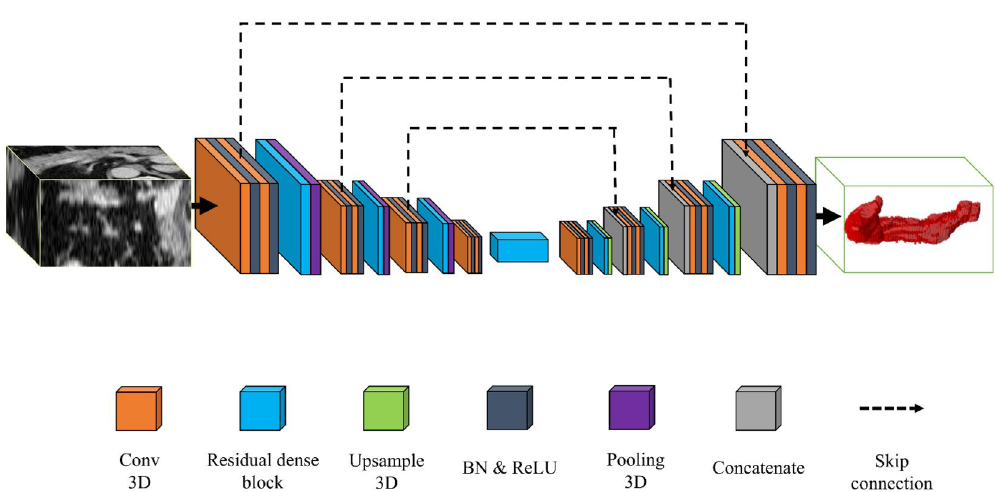
Figure 2. Architecture illustration of residual dense u-net. Conv, convolution; BN, batch normalization; ReLU, rectified linear